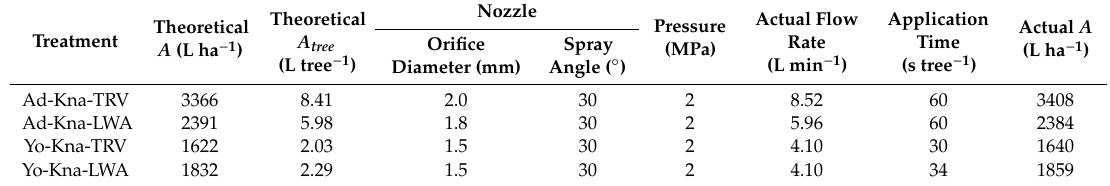
Table 3. Working conditions for the treatments with the knapsack sprayer.